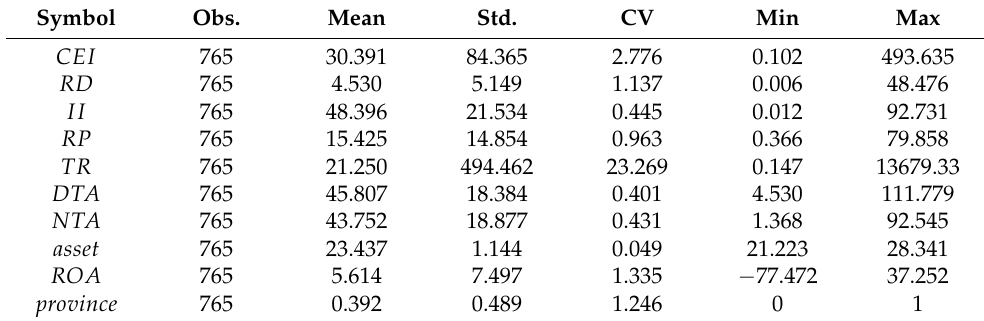
Table 3. Descriptive statistics of